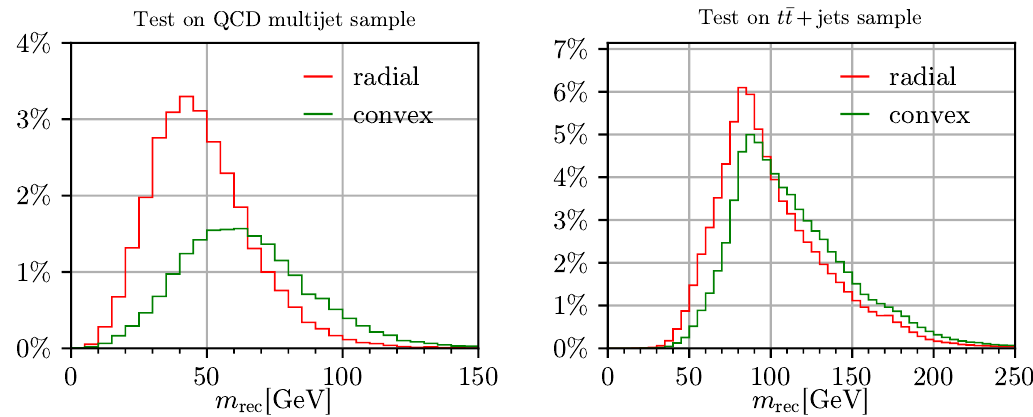
Figure 8. The reconstructed (highest score) Higgs invariant mass distributions from our networks being tested on the QCD multijet sample and t ¯ t + jets sample. Only events which contain at least one CNN tagged Higgs jet with score greater than 0.9 are